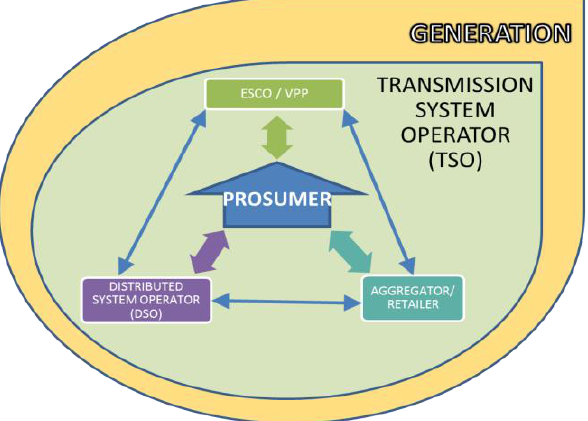
Figure 6. New prosumer-centered energy market value